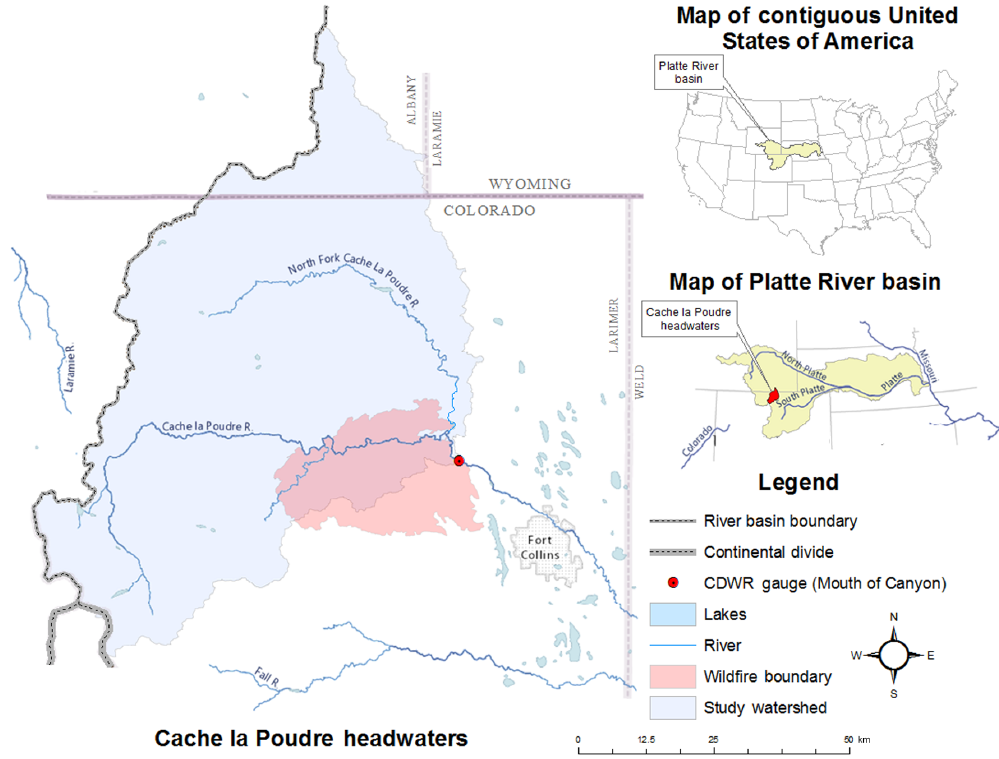
Figure 1. Study area map which includes the location of the study watershed and the CDWR surface water